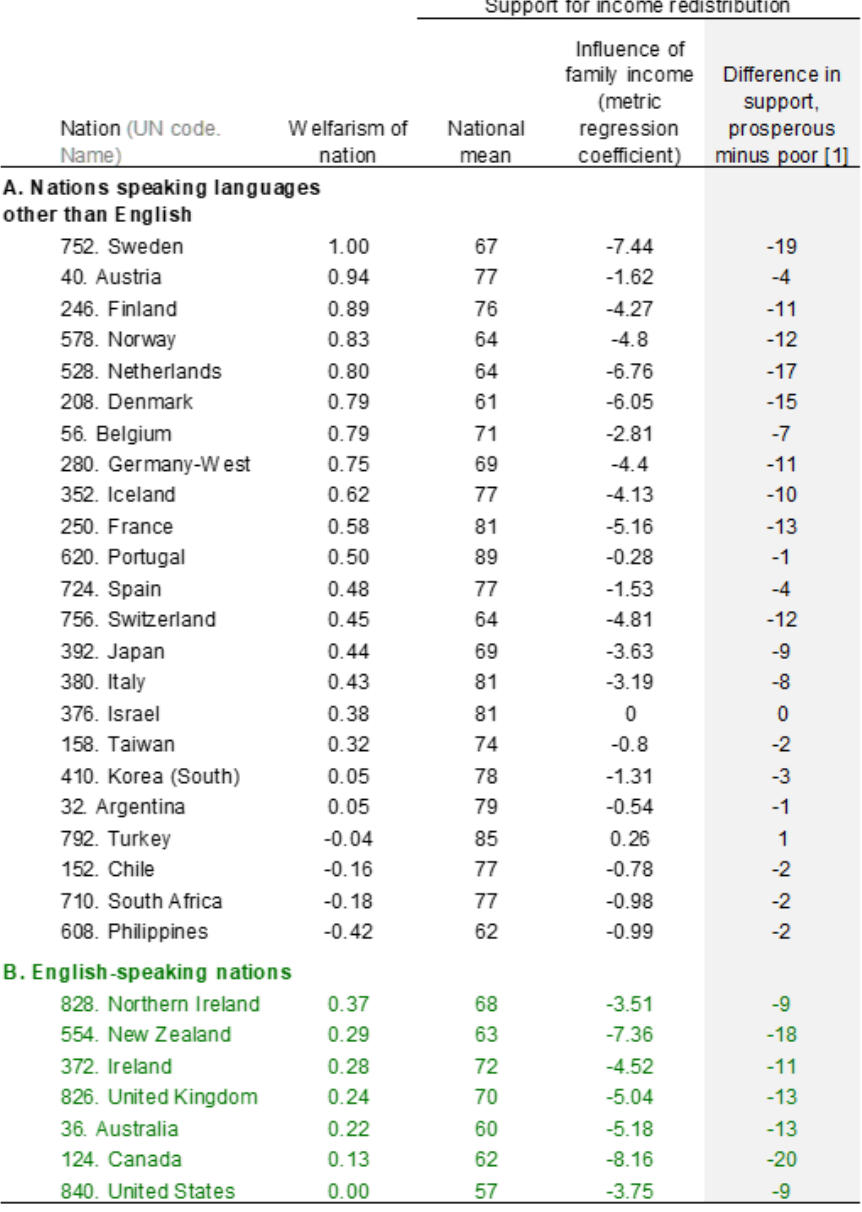
Figure 18. Effect of family income on support for income redistribution (points out of 100). OLS regression estimates separately for each nation, controlling for gender, date of birth, and education. Number of cases shown in the previous figure. Nations ordered by language and